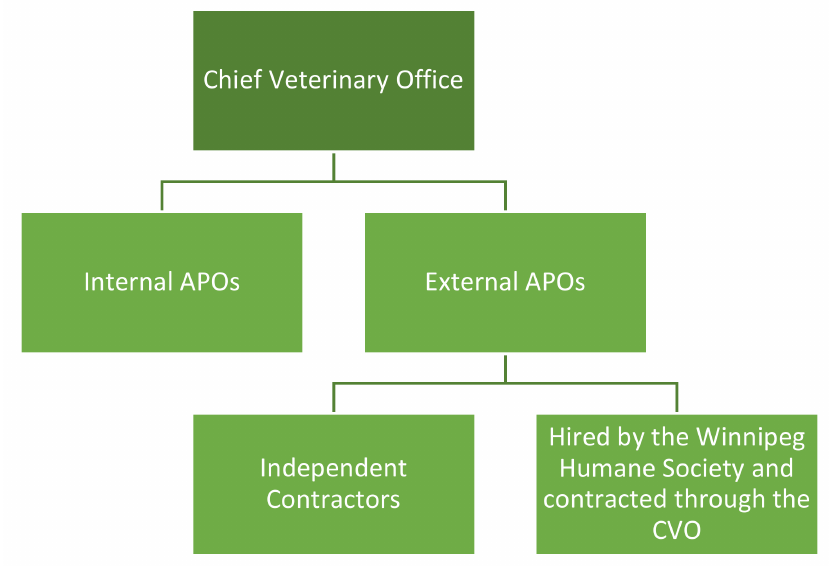
Figure 1. Types of Animal Protection O ffi cers (APOs) in